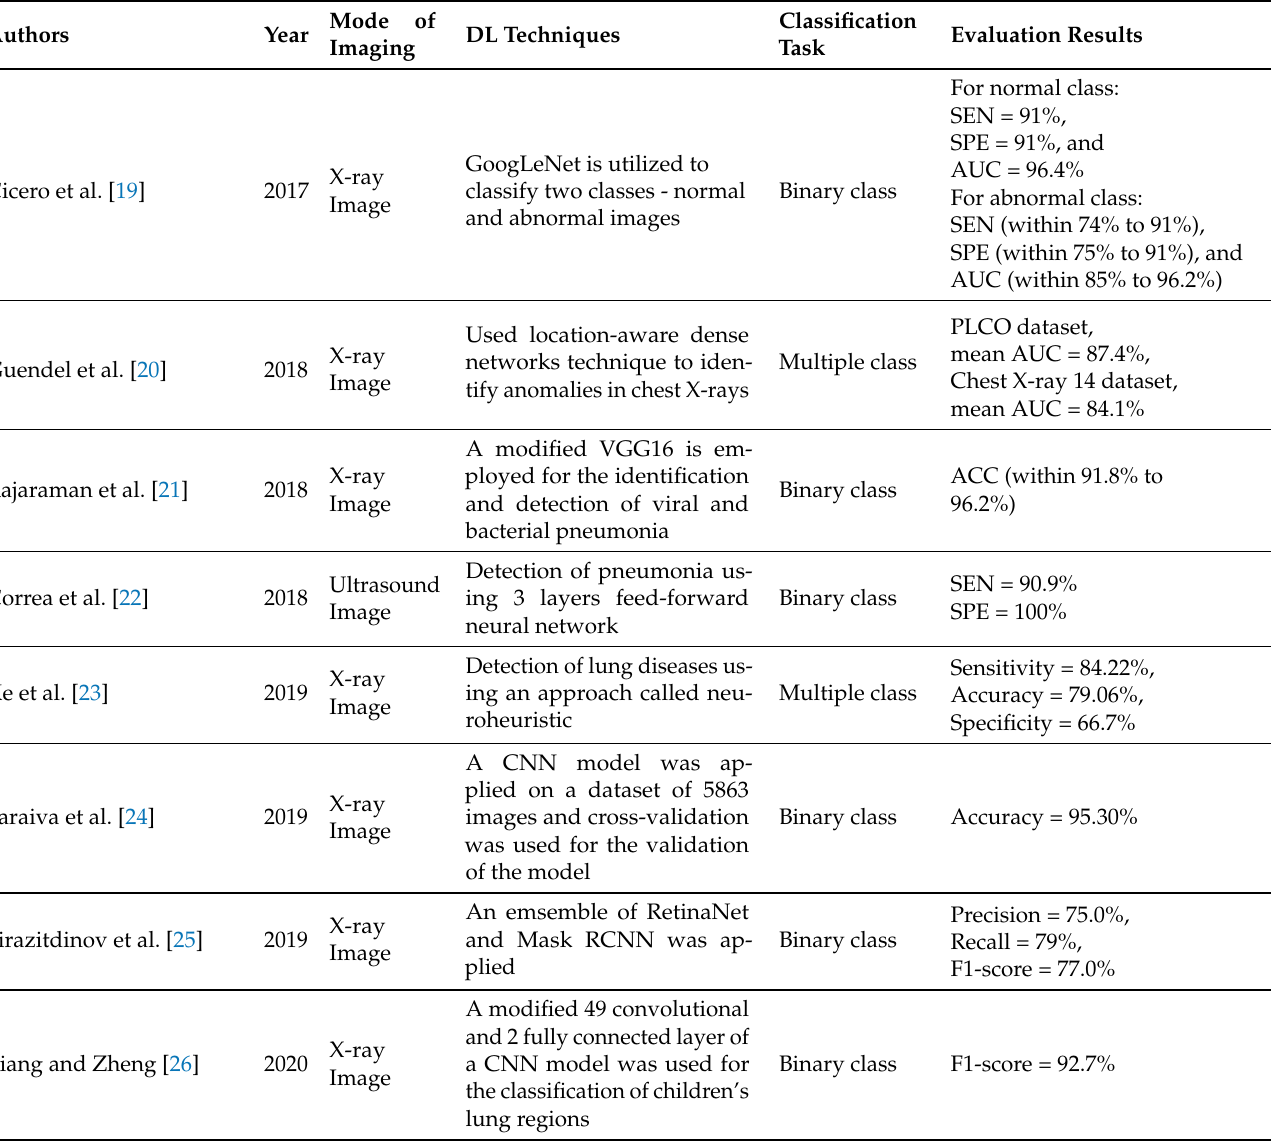
Table 1. Summary of the Related